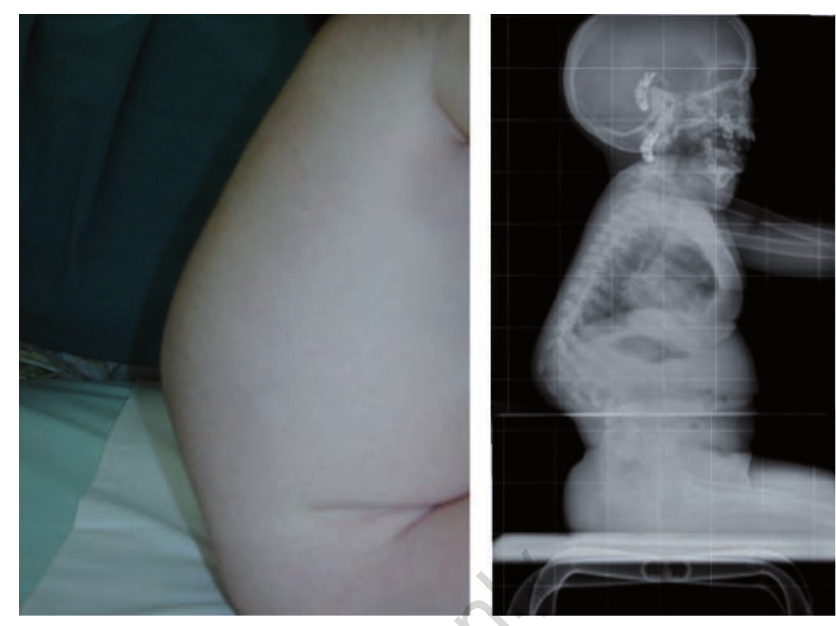
Figure 1. Early appearance of gibbus at 9 months of life and X-ray evolution after few years.